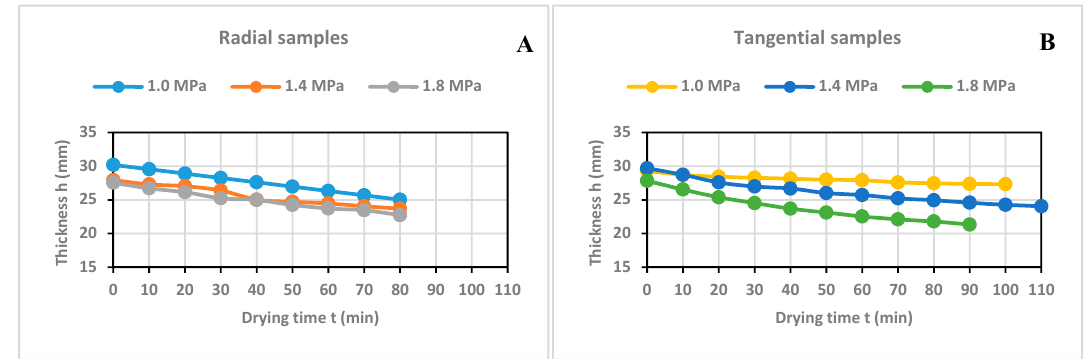
Figure 7. Change in the thickness in the ( A ) radial and ( B ) tangential samples during contact-drying.